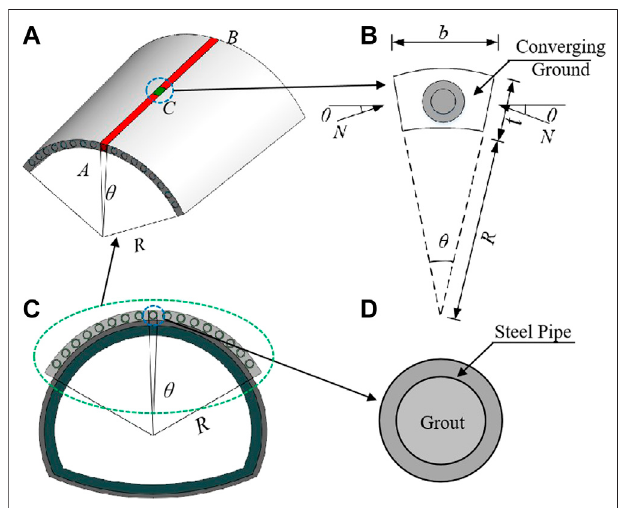
FIGURE 1 | Force analysis of the grouting area in the